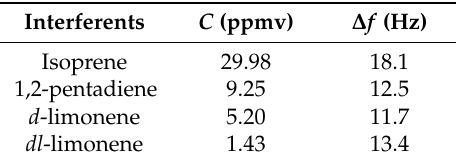
Table 2. Response of [bmim][BF 4 ]-modified QCM sensor to four common interferents.